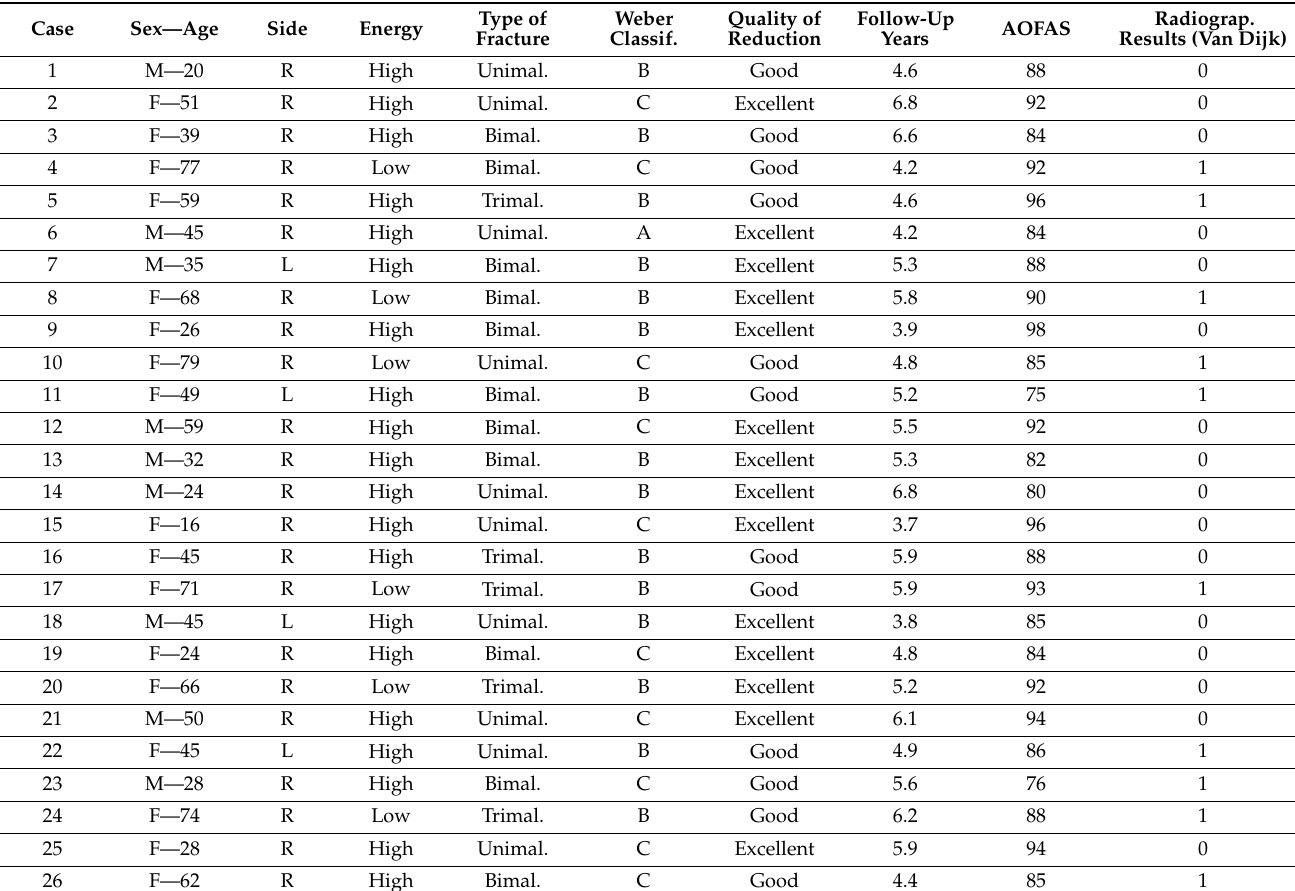
Table 1. Demographics, clinical, and radiological results of our cohort of